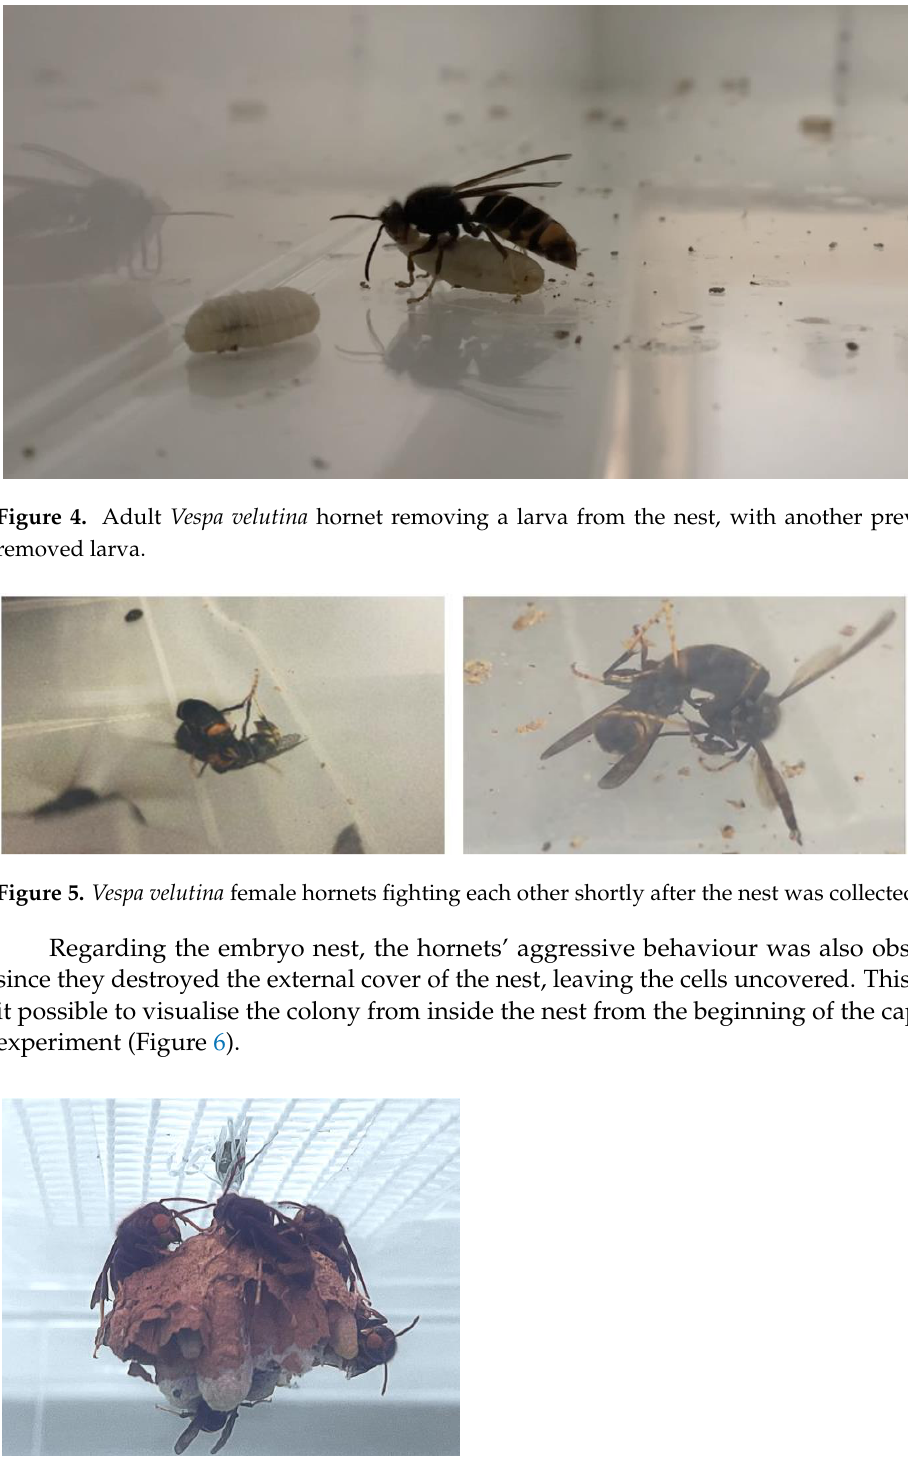
Figure 6. Embryo nest of Vespa velutina in the captivity cage after 2 days of